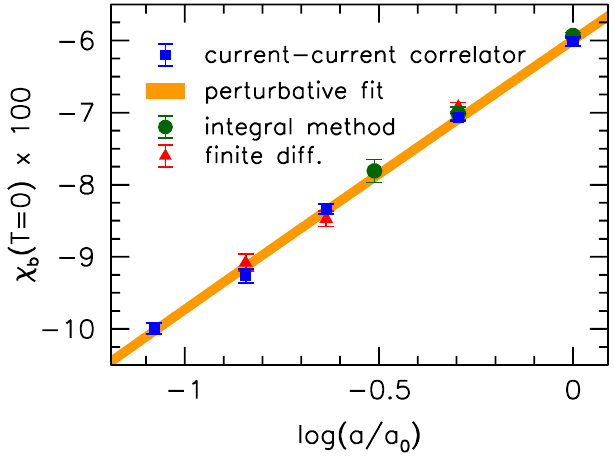
Figure 3 . Bare magnetic susceptibility at zero temperature versus the logarithm of the lattice spacing, normalized to a 0 = 1 : 46 GeV (cid:0) 1 . Di(cid:11)erent approaches are compared: the (cid:12)nite di(cid:11)erence method [47] (red triangles), the generalized integral method [28] (green circles) and the new ap- proach via current-current correlators (blue squares). The orange band indicates the (cid:12)t based on perturbation theory, eq.